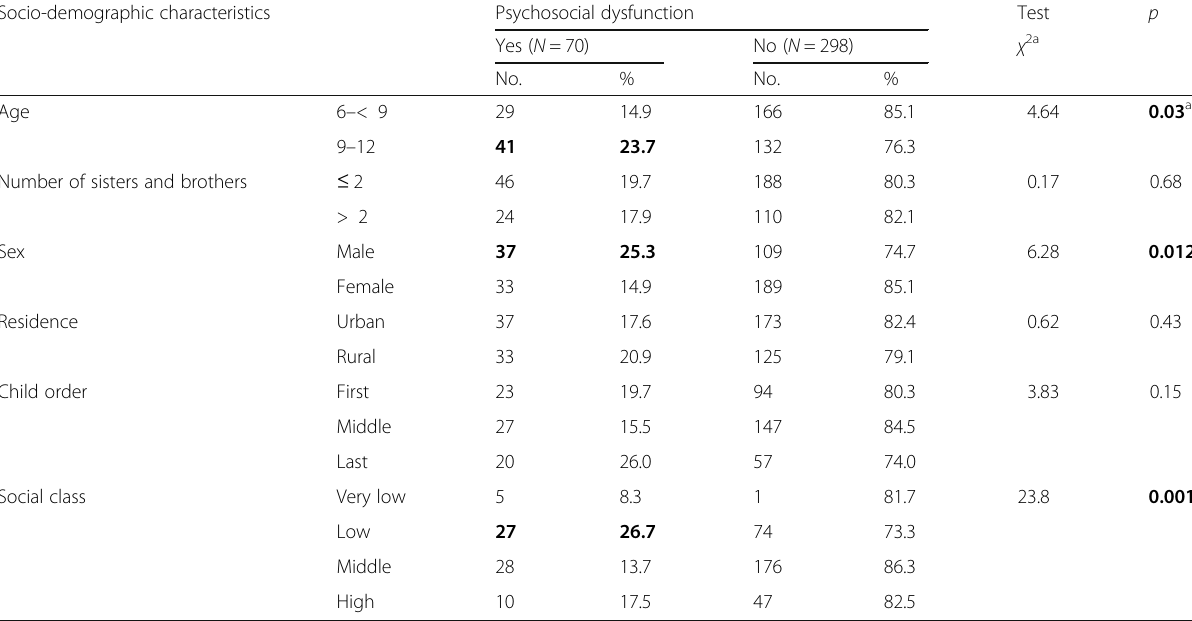
Table 4 Association between socio-demographic characteristics of the studied children and CPD Socio-demographic characteristics Psychosocial